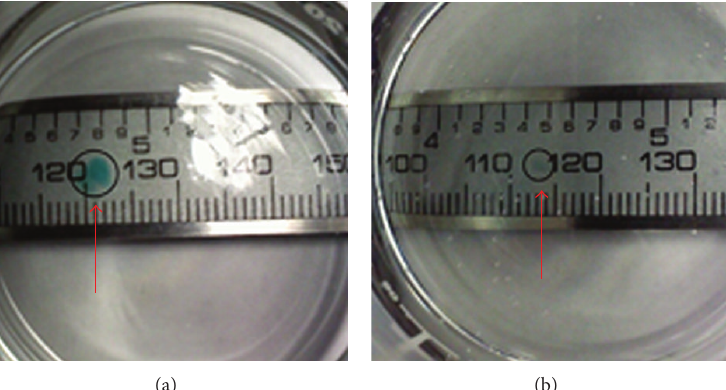
Figure 1: Results of TA bead denaturation studies. TA beads were dyed blue and then subjected to denaturation studies. Beads are in a clear dish over a ruler. (a) Dyed TA bead prior to denaturation; (b) remains of TA bead following denaturation. Arrows indicate bead prior to (a) denaturation or (b) after denaturation.